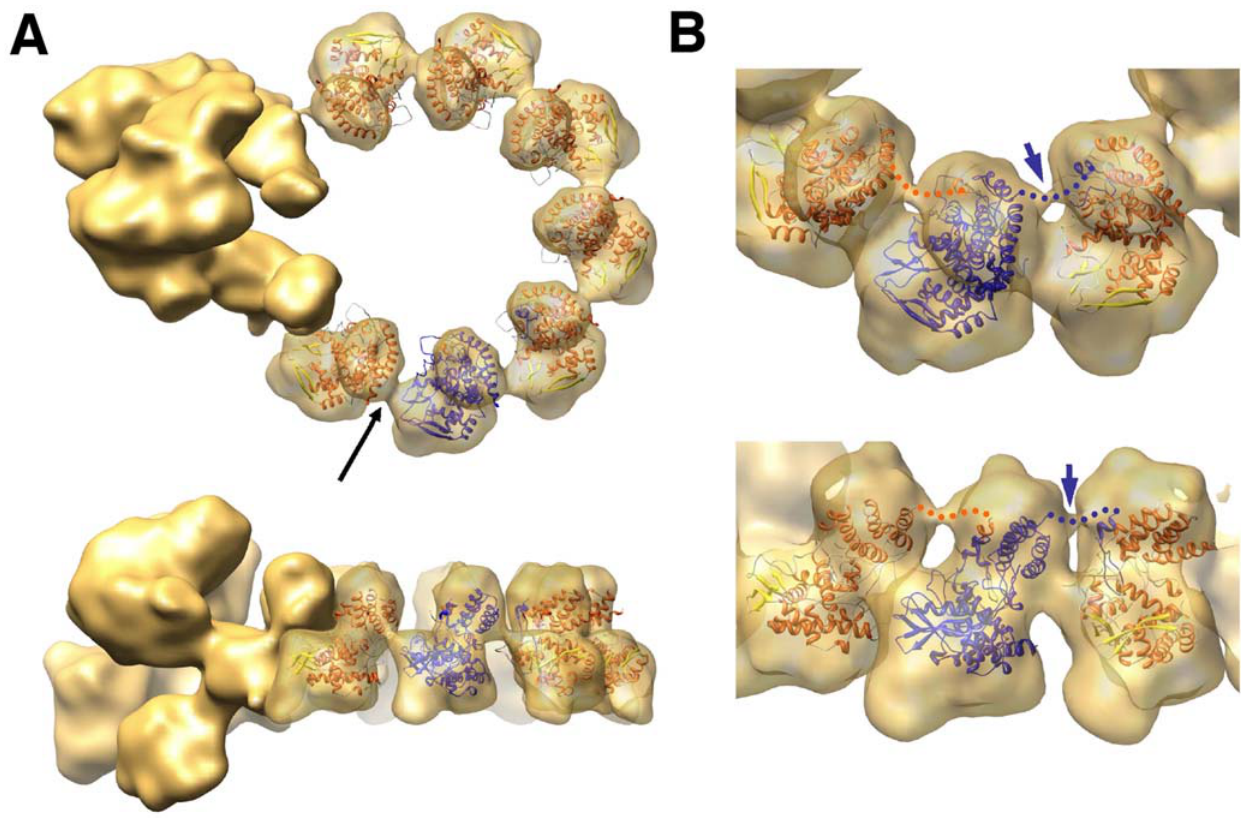
Figure 4. Docking the atomic structure of NP monomers into the RNP model. (A) The atomic structure of NP [21] is represented within the volume of the NP monomers derived from a reconstruction obtained imposing 9-fold symmetry. Upper and side views are presented. One of the monomeric atomic structures is highlighted in blue to reveal the localisation of the connecting loop within the neighbouring monomer. The black arrow points to the potential RNA connection among NP monomers. (B) Close-up view of three NP monomers represented at s =1.5. Upper and perspective views are shown. The blue arrow points to the connection between the NP monomers at the top of the molecules. The presumptive connection of the NP head and the loop inserted in the neighbouring monomer is indicated by a dotted line.